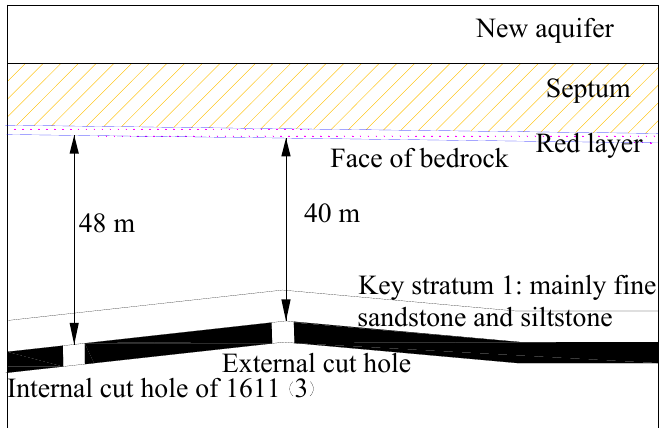
Figure 1. Cross-section view of the 1611 (3) working face in the Zhangji Coal Mine.